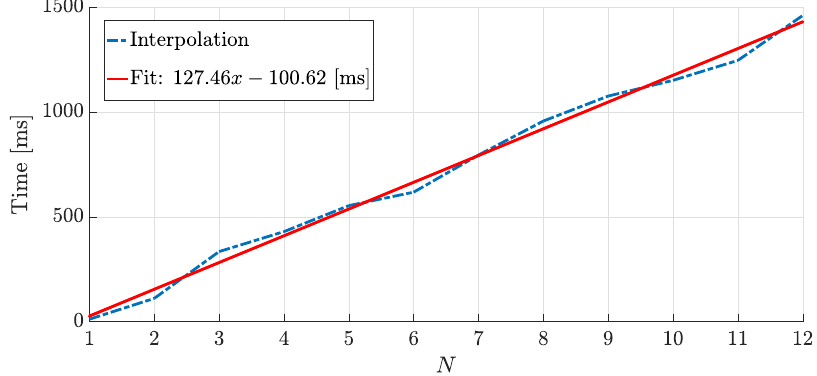
Figure 8. Time required to complete the DAO-EBR phase with CCR set to 8 Hz (metric T-DAO-EBR).